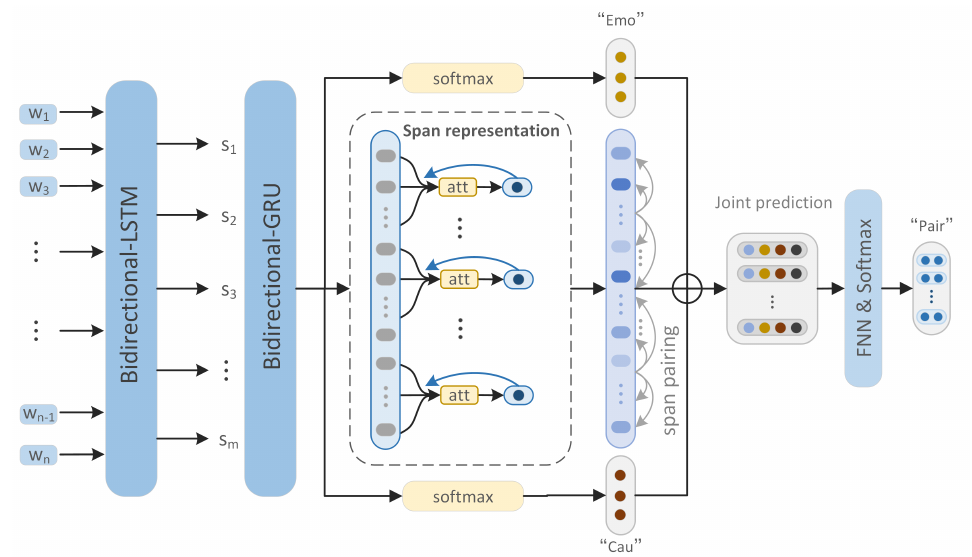
Figure 2. The general framework SAP-ECPE for ECPE tasks is introduced. The model consists of three parts, namely span representation, span pairing, and joint prediction, where Emo represents the prediction of the emotion clause and Cau represents the prediction of the cause-clause, span pairing represents the span association pairing module; and joint prediction represents the multidimensional information joint prediction